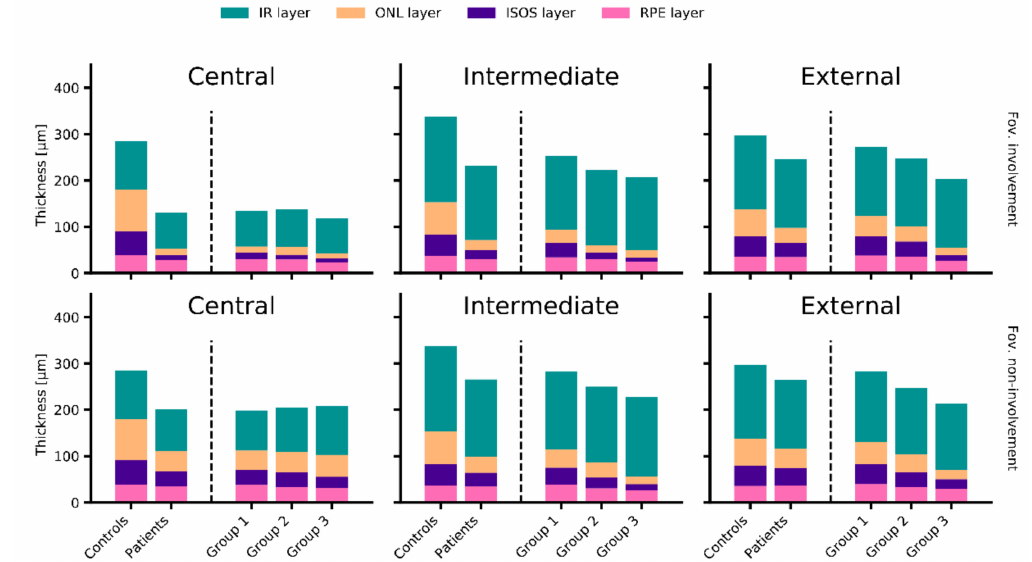
Figure 2. Retinal layer thickness measurements, eccentricity and foveal status. The bar plots demonstrate the mean retinal layer thickness measurements in the central subfield (first column), intermediate subfields (second column) and external subfields (third column) of the ETDRS, for controls’ and patients’ eyes depending on the presence (first row) or absence (second row) of foveal involvement. Patients’ eyes were further divided according to full-field electroretinogram based group classifications. Compared to controls, patients’ eyes revealed reduced retinal thickness in each eccentricity, especially in the outer nuclear layer (ONL, yellow) and the photoreceptor inner and outer segment layers (ISOS, purple). In the central subfield, the retinal thinning was expressed in eyes assigned to all groups of patients, while in the more eccentrically subfields, it was increasingly expressed from group 1 over group 2 to group 3 eyes. Concerning the foveal status, the most obvious di ff erence was noticeable in the central subfield, where the retinal thinning was distinctly more pronounced in eyes with foveal involvement. The bar plots and exact numbers of measurements according to each ETDRS subfield can be found in Supplementary Figure S3 and in Supplementary Table S2, respectively. IR: inner retina (green), RPE: retinal pigment epithelium